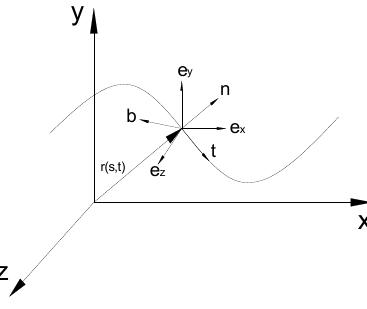
Figure 2. Coordinate system of the beam.